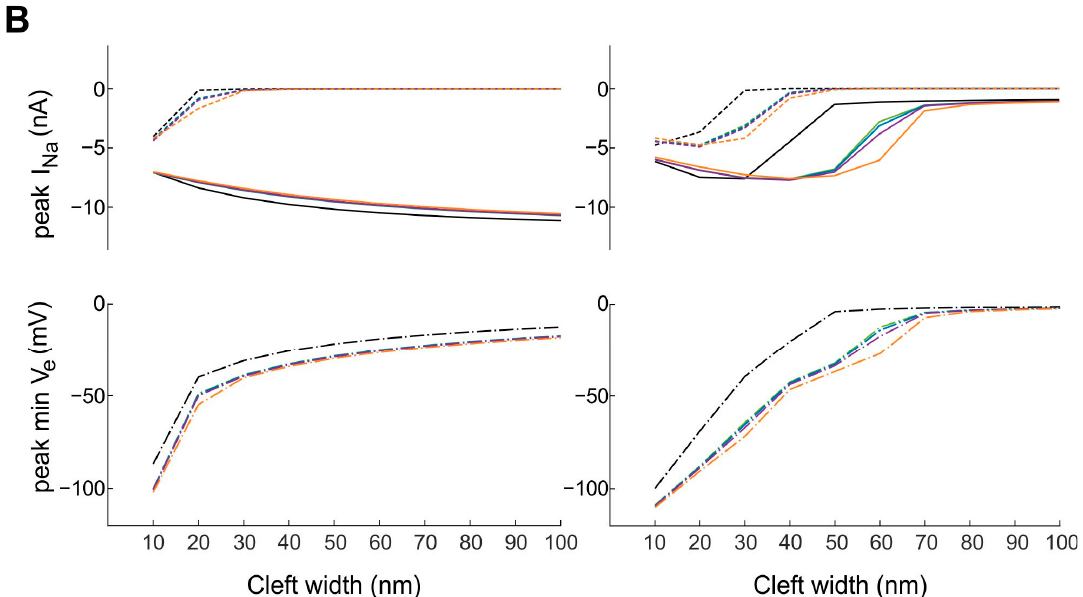
Figure 4. Effects of jointly changing the number N and amplitude A of concentric folds such that their product remains constant (A ∙ N = 1/2 R ID ) on ephaptic coupling (uniform distribution of g Na ). The intracellular nodes were subjected to a voltage clamp protocol with V step = –25 mV (left) and V step = –50 mV (right). ( A ) The cleft width was set to 30 nm. Continuous and dotted curves corre- spond to I Na in the pre- and post-junctional membranes, respectively. Reference simulations with a flat intercalated disc (ID) are shown in black. ( B ) Peak I Na and peak minimal V e for the same combi- nations of A and N (color coding as in A) when cleft width was varied from 10 to 100 nm in steps of 10 nm.